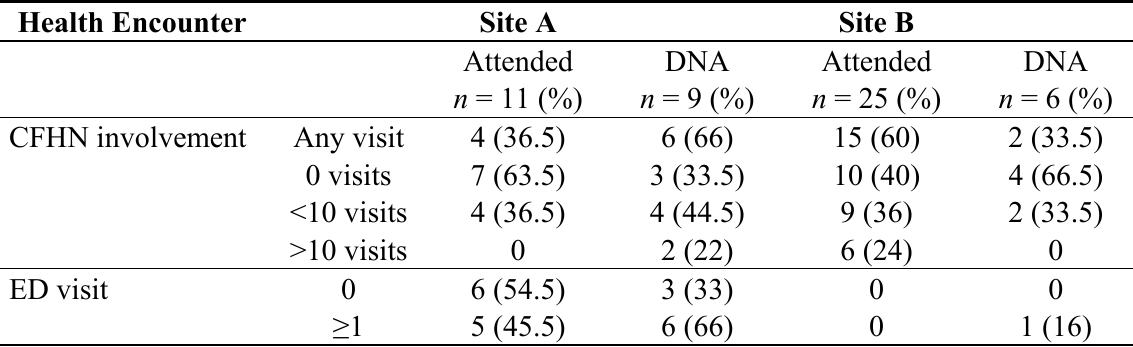
Table 4. Health encounters of clinic attendees versus